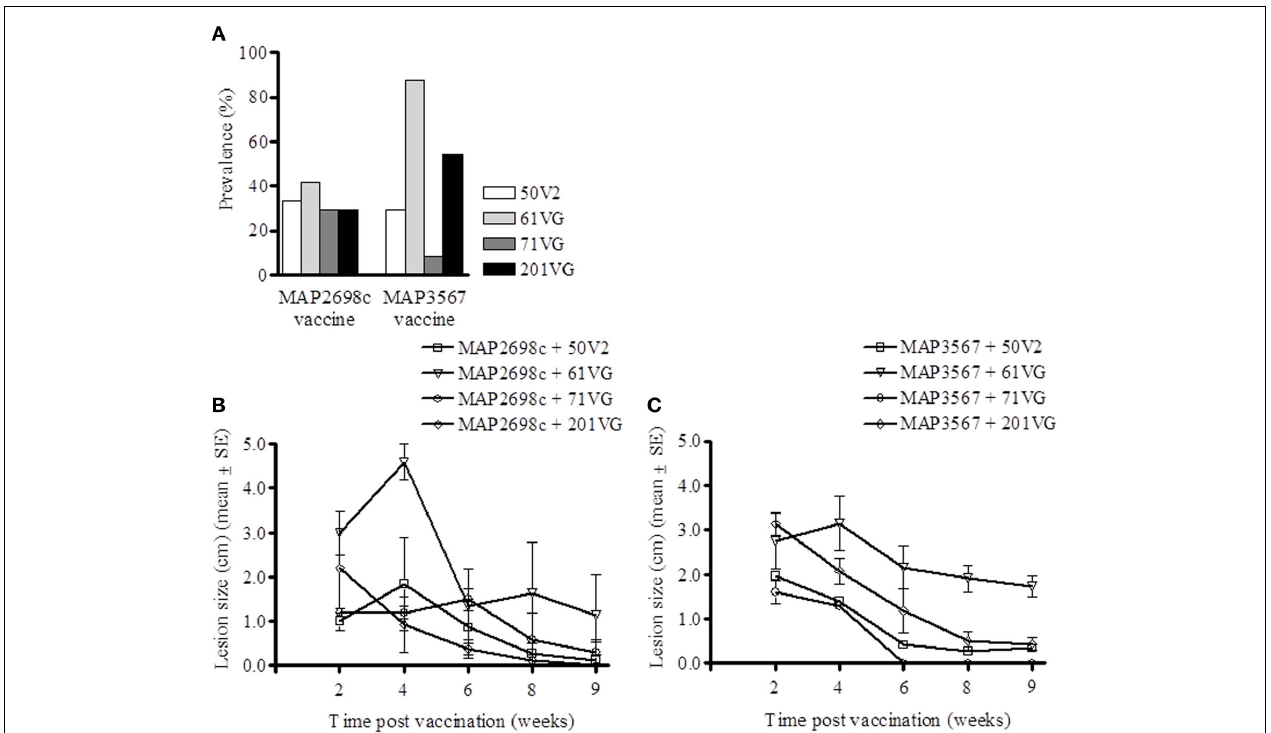
FIGURE 5 | Vaccine injection site lesion prevalence and lesion size. (A) Lesion prevalence during the study period; (B) Vaccine formulation (MAP2698c + adjuvants) lesion size and trend; and (C) Vaccine formulation (MAP3567 + adjuvants) lesion size and trend. Data are mean ± SE .